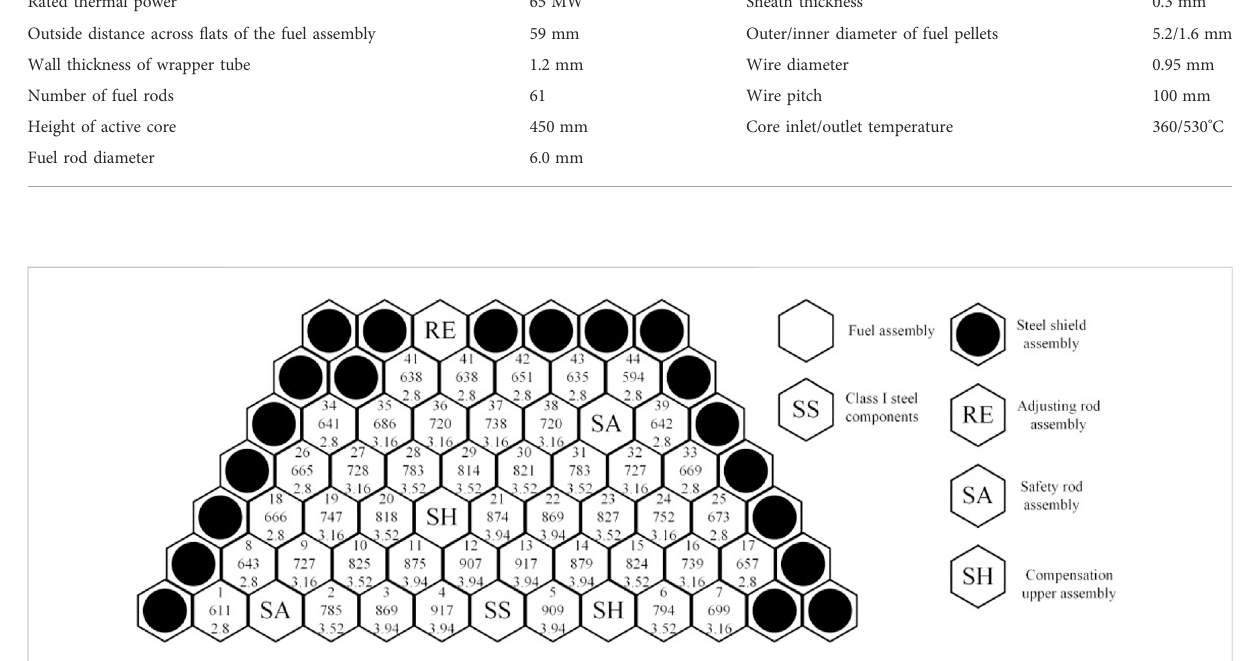
FIGURE 4 Distribution of channel number, power, and fl ow rate for analysis of the 1/2 core